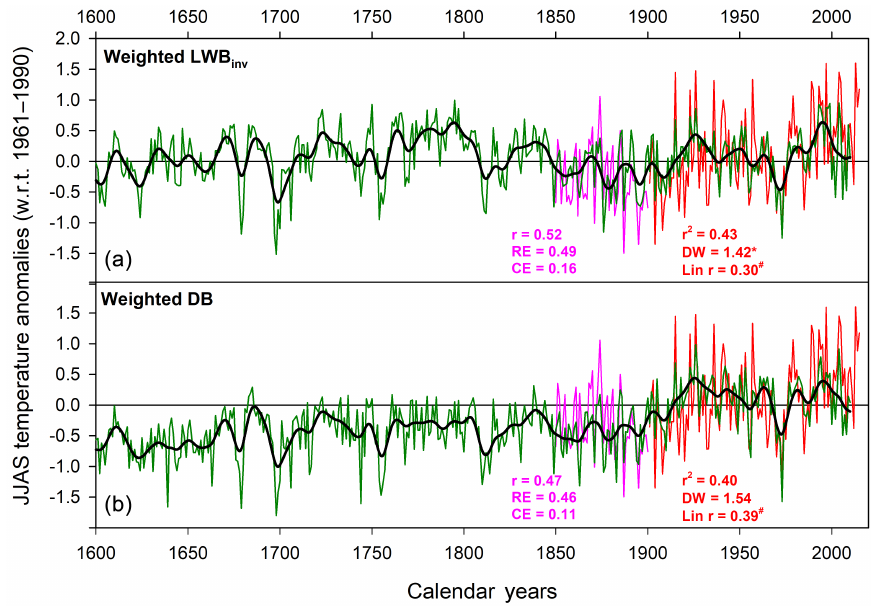
Figure 7. Extended reconstruction tests using LWB inv and DB regional weighted averages. The 1901–2010 period calibration uses CRU TS 3.24 data (red) while validation is performed using BEST data (pink) over the 1850–1900 period. ∗ denotes significant first-order autocor- relation in model residuals; # denotes a significant linear trend in the model residuals. The smoothed functions are 15-year cubic smoothing